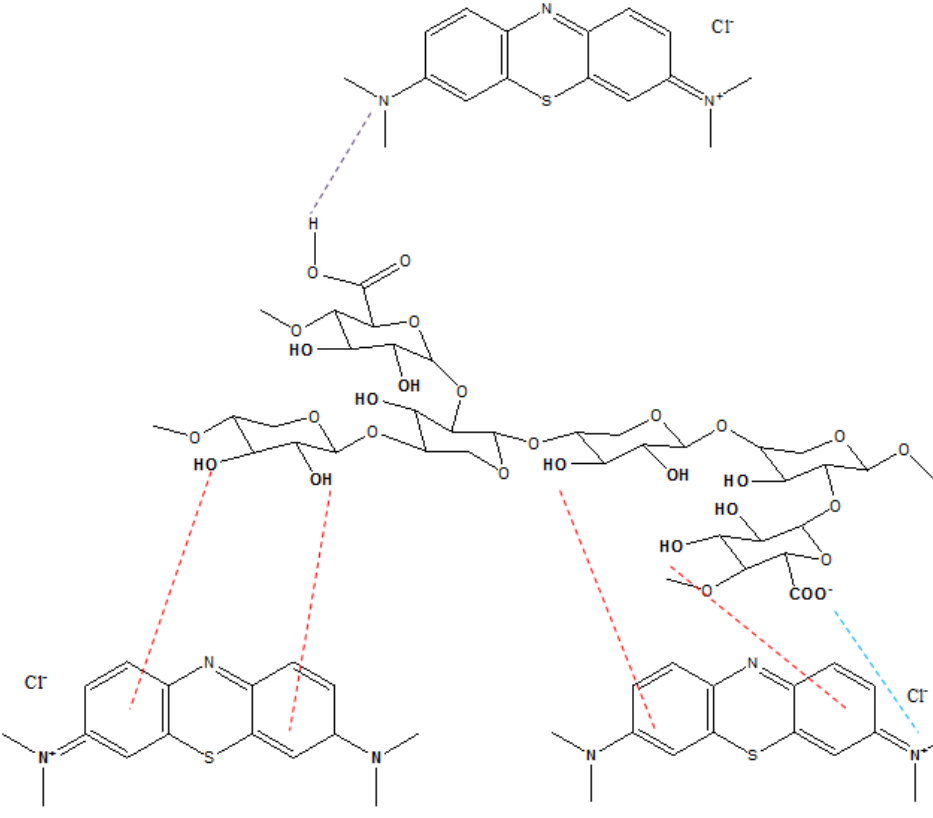
Figure 12. Proposed mechanism for MB adsorption by CCSs and CCPs.